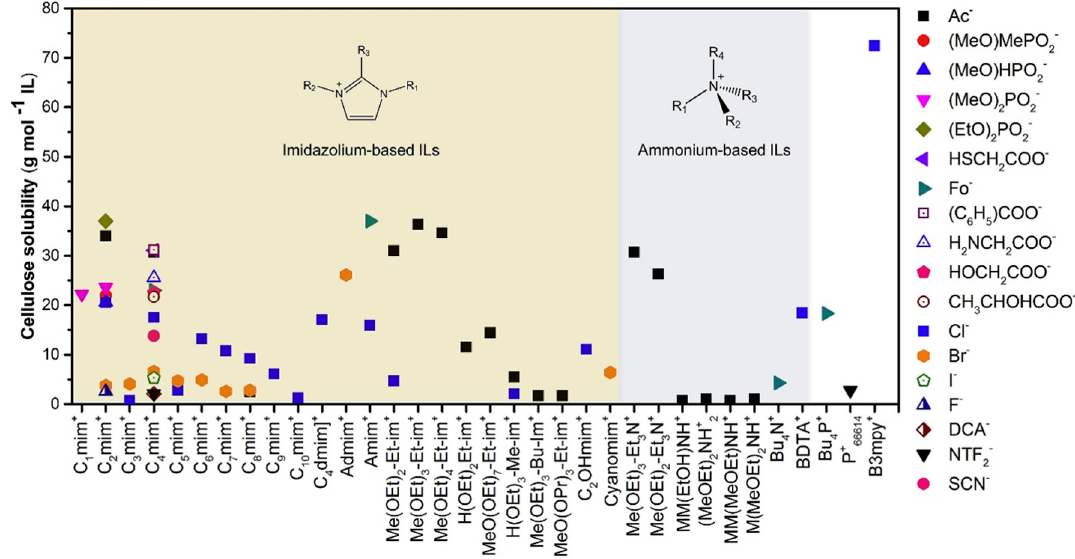
Figure 3. Solubility of cellulose in various ionic liquids (ILs) [33].